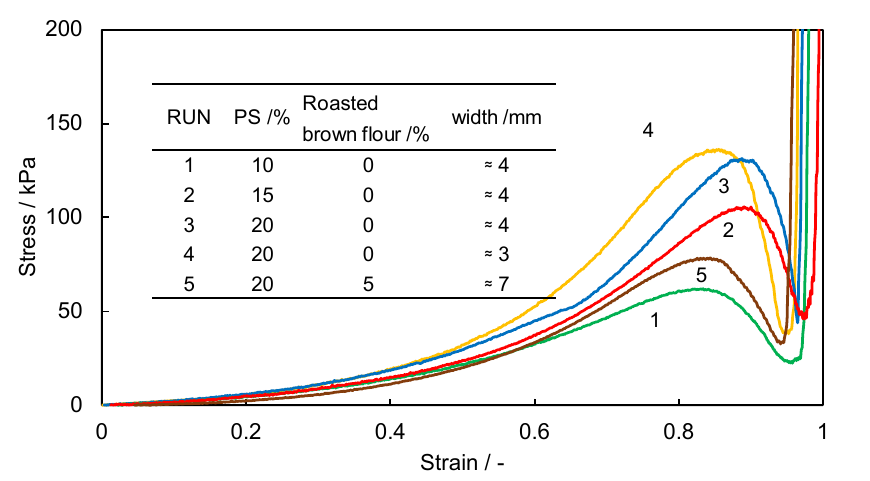
Figure 5. Stress–strain diagram of cooked rice noodles: a representative measurement of each condition. “ ≈ ” means “approximately equal”.